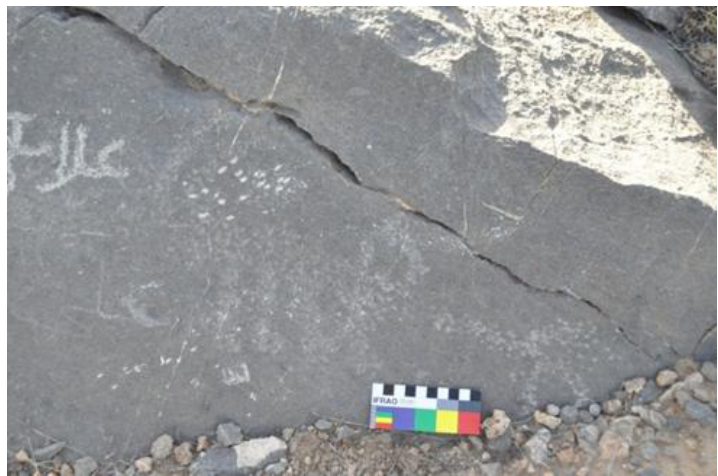
Figure 3. Ghārā-Tepe I, panel 1, zoomorphs.